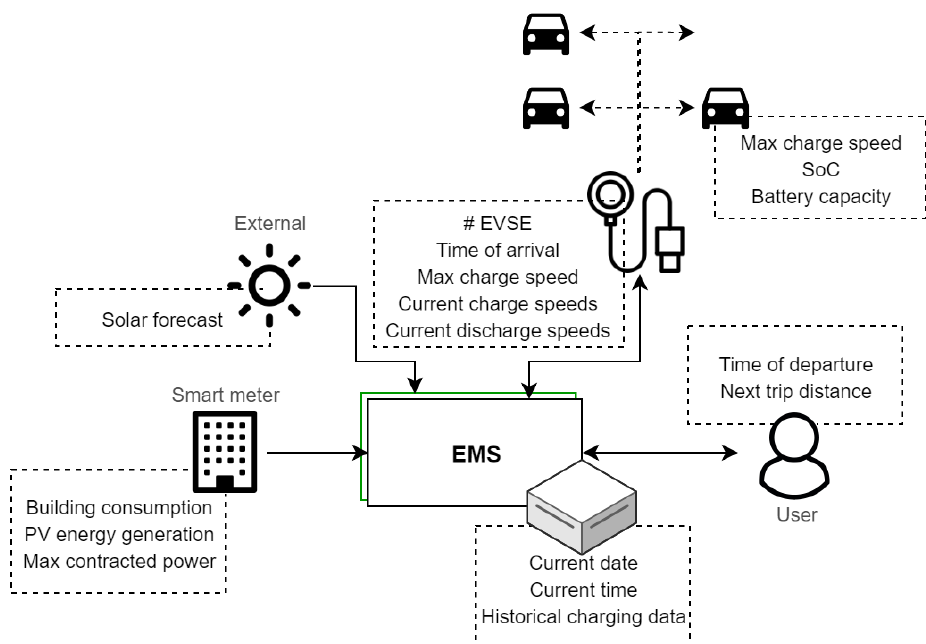
Figure 14. Data and their sources used in the future system design.